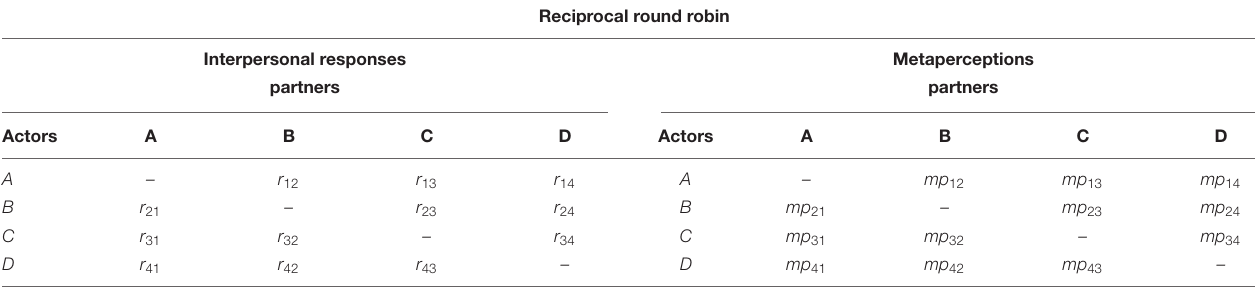
TABLE 1 | Multiple interaction designs for ARRMA estimation.